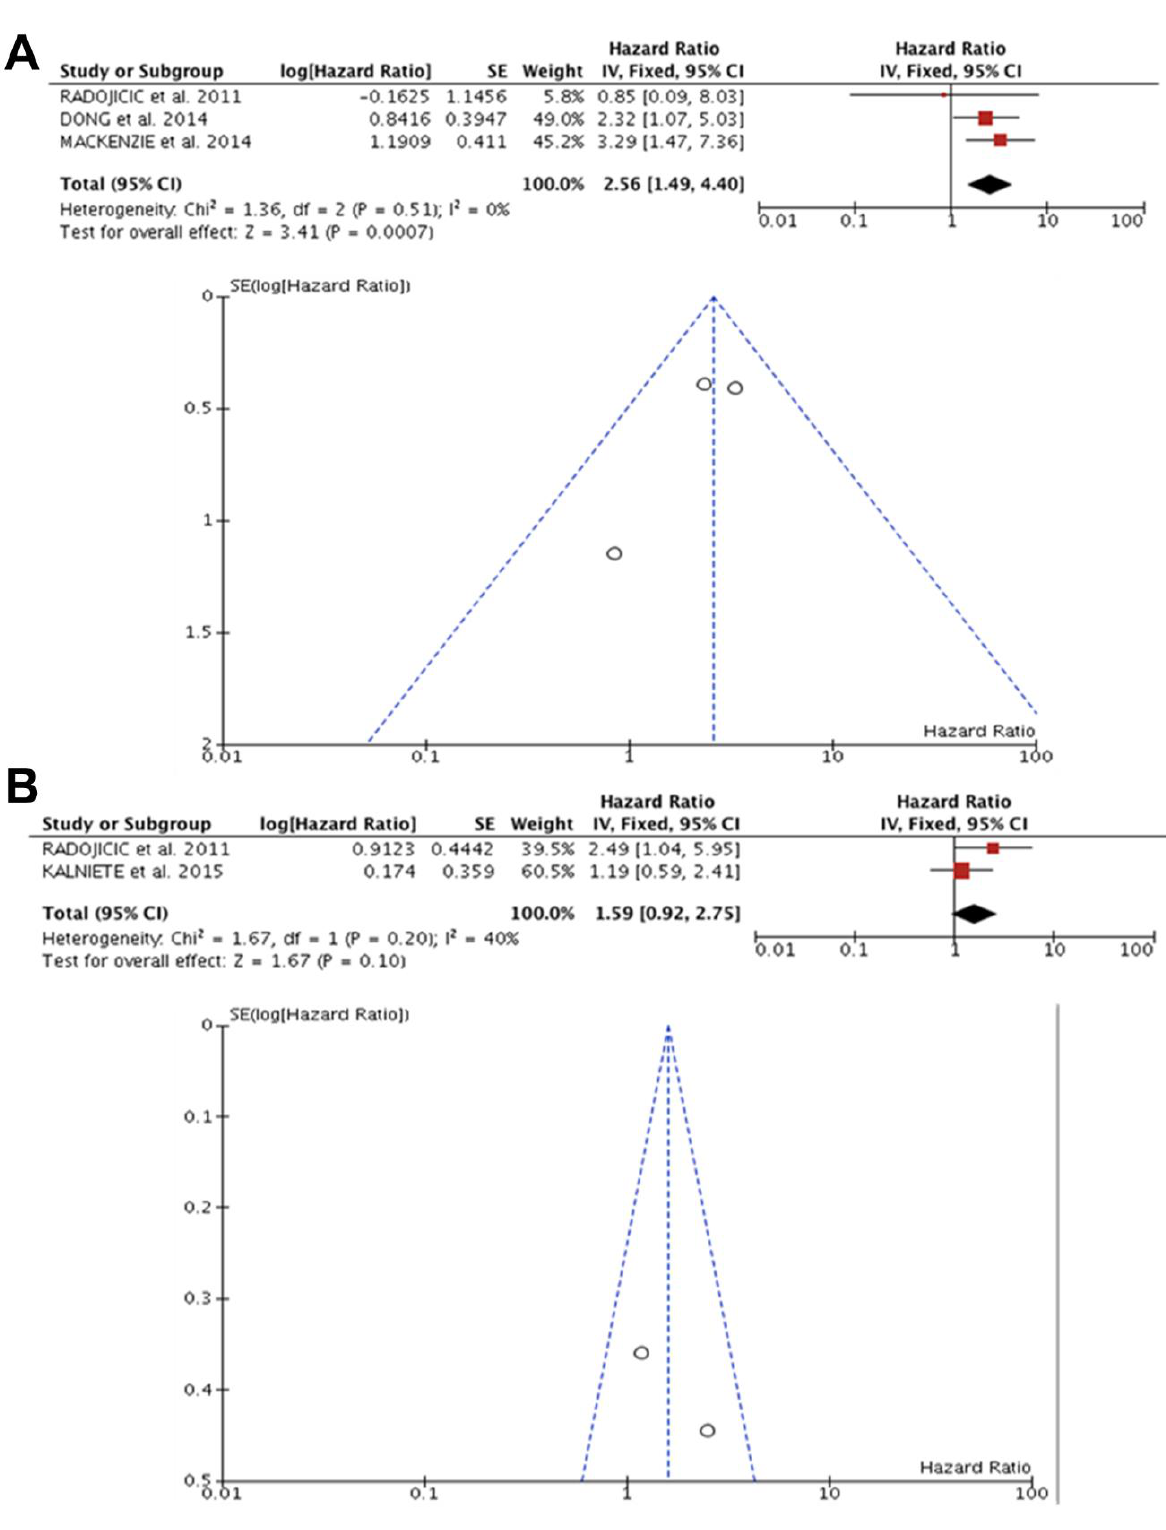
Figure 3. miR-21 and prognosis in TNBC. (A) Forest and funnel plot showed that high miR-21 expression was related to worse OS prognosis in patients with TNBC (HR: 2.56; 95%CI: 1.49 – 4.40; I2 = 0.0%, p = 0.51) [41,53,54]. (B) Forest and funnel plot presented DFS in patients with TNBC was not related to a worse prognosis. Homogeneity was observed, but the effect was not significant (HR: 1.59; 95% CI: 0.92 – 2.75; I2 = 40%, p = 0.20) [45,54].